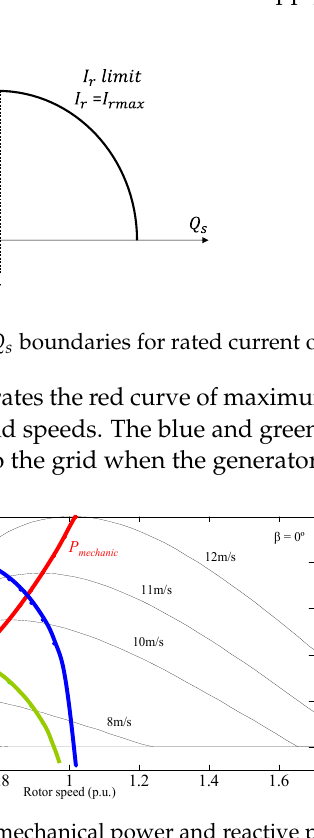
Figure 10. Maximum mechanical power and reactive powers obtainable for maximum rotor current. DFIG 7.5 kW, green curve. DFIG 1.2 MW, blue curve. The blue 𝑄 𝑠 line corresponds to a 1.2 MW DFIG and the green line to a 7.5 kW DFIG.